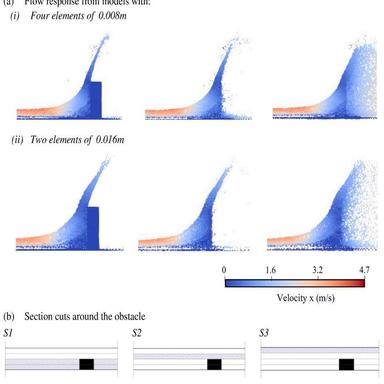
(a) Impact mechanisms captured from MPM simulations across the (b) sections of the flume.